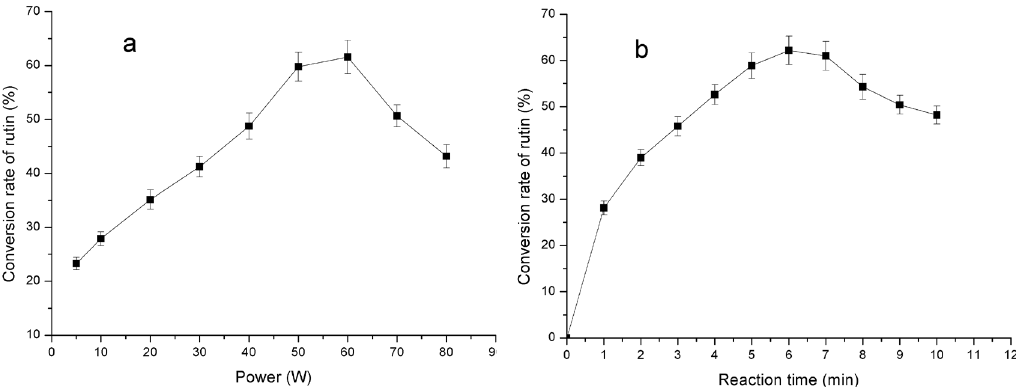
Figure 3. Effect of irradiation power ( a ) and time ( b ) on rutin transglycosylation in the microwave-assisted reaction (MAR) system (reaction temperature not exceeding 50